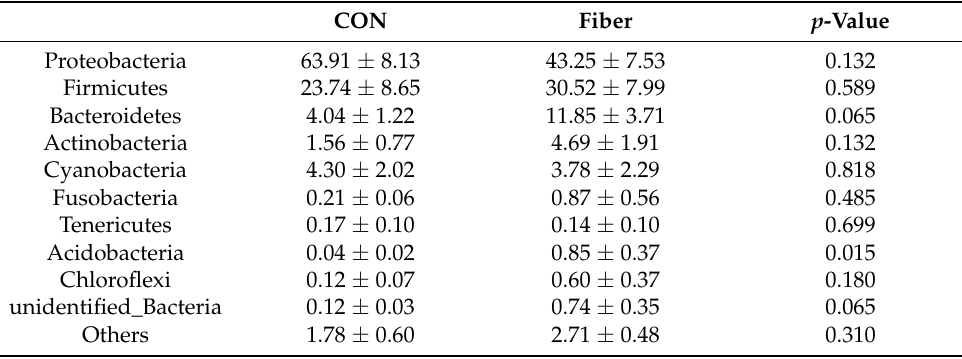
Table 4. The relative abundance of main bacterial phyla in the colon of newborn piglets.